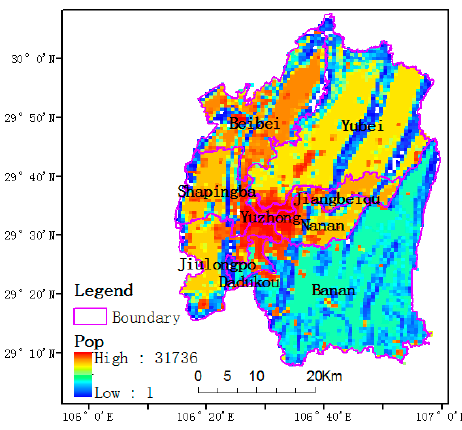
Figure 4. Population density distribution in 2010.